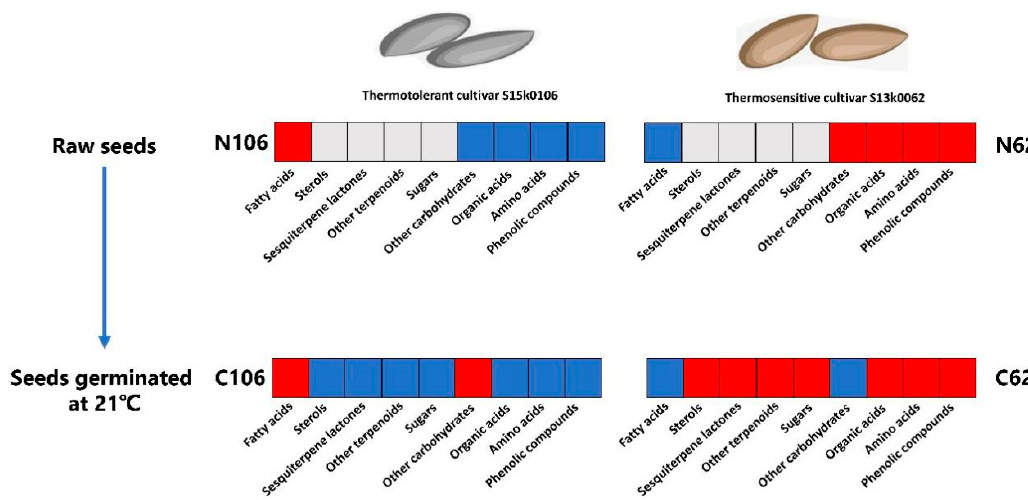
Figure 3. Differential metabolites detected between the thermotolerant and thermosensitive lettuce cultivars. Note: The heatmap indicates the differential metabolites extracted from raw S15k0106 (N106) and S13k0062 (N62) seeds and germinated buds of S15k0106 (C106) and S13k0062 (C62) seeds. A red box means that most of the metabolites in this class had higher relative abundances in a treatment than those in another in a pair of comparison (N106 vs. N62 or C106 vs. C62), while a blue box represents that relative abundances of most of the metabolites in this class were lower in a treatment than those in another between the two treatments; a gray box denotes no significance between two treatments.